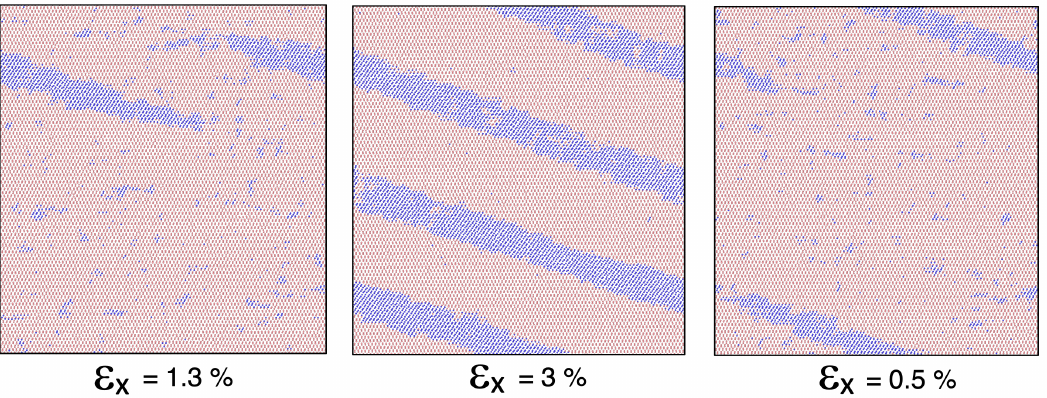
Figure 5. Fragment of the calculation cell for the deformation (cid:101) x = 1.3 %, final state (cid:101) x = 3 %, and deformation (cid:101) x = 0.5 % during reverse compression (two atomic planes are shown): red atoms correspond to the α (cid:48)(cid:48) -phase and blue atoms to the γ 0 -phase.